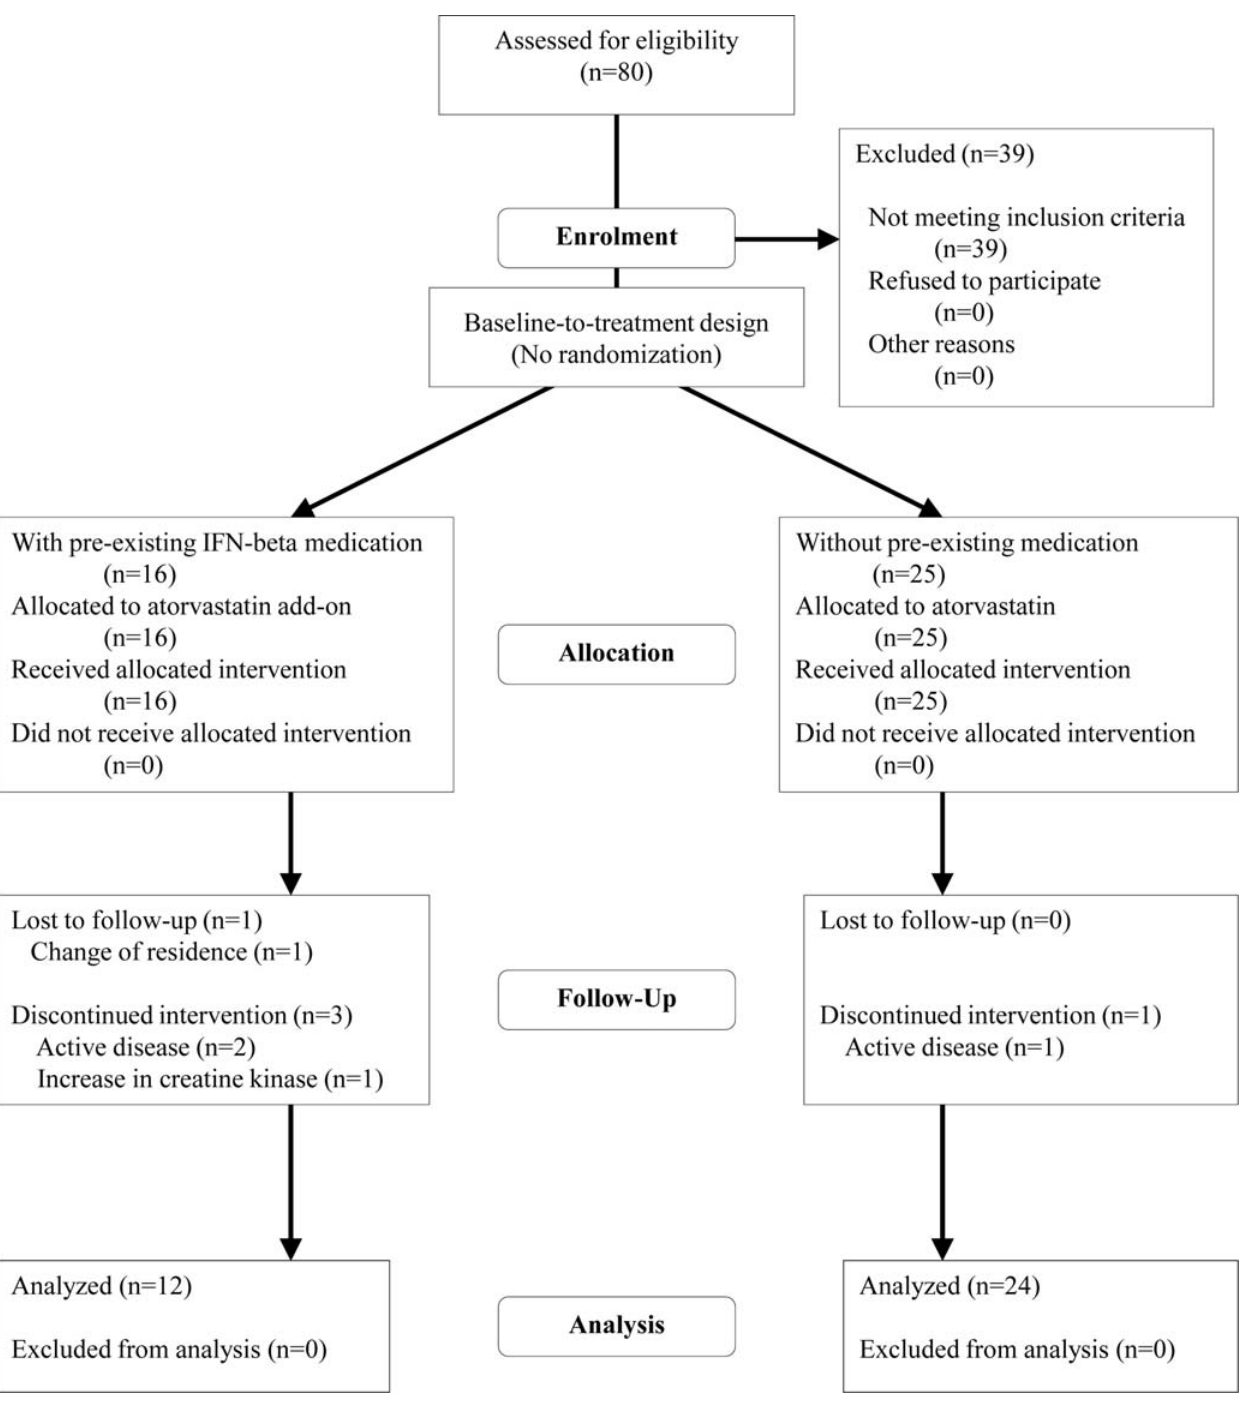
Figure 1. Flow chart of study patients.